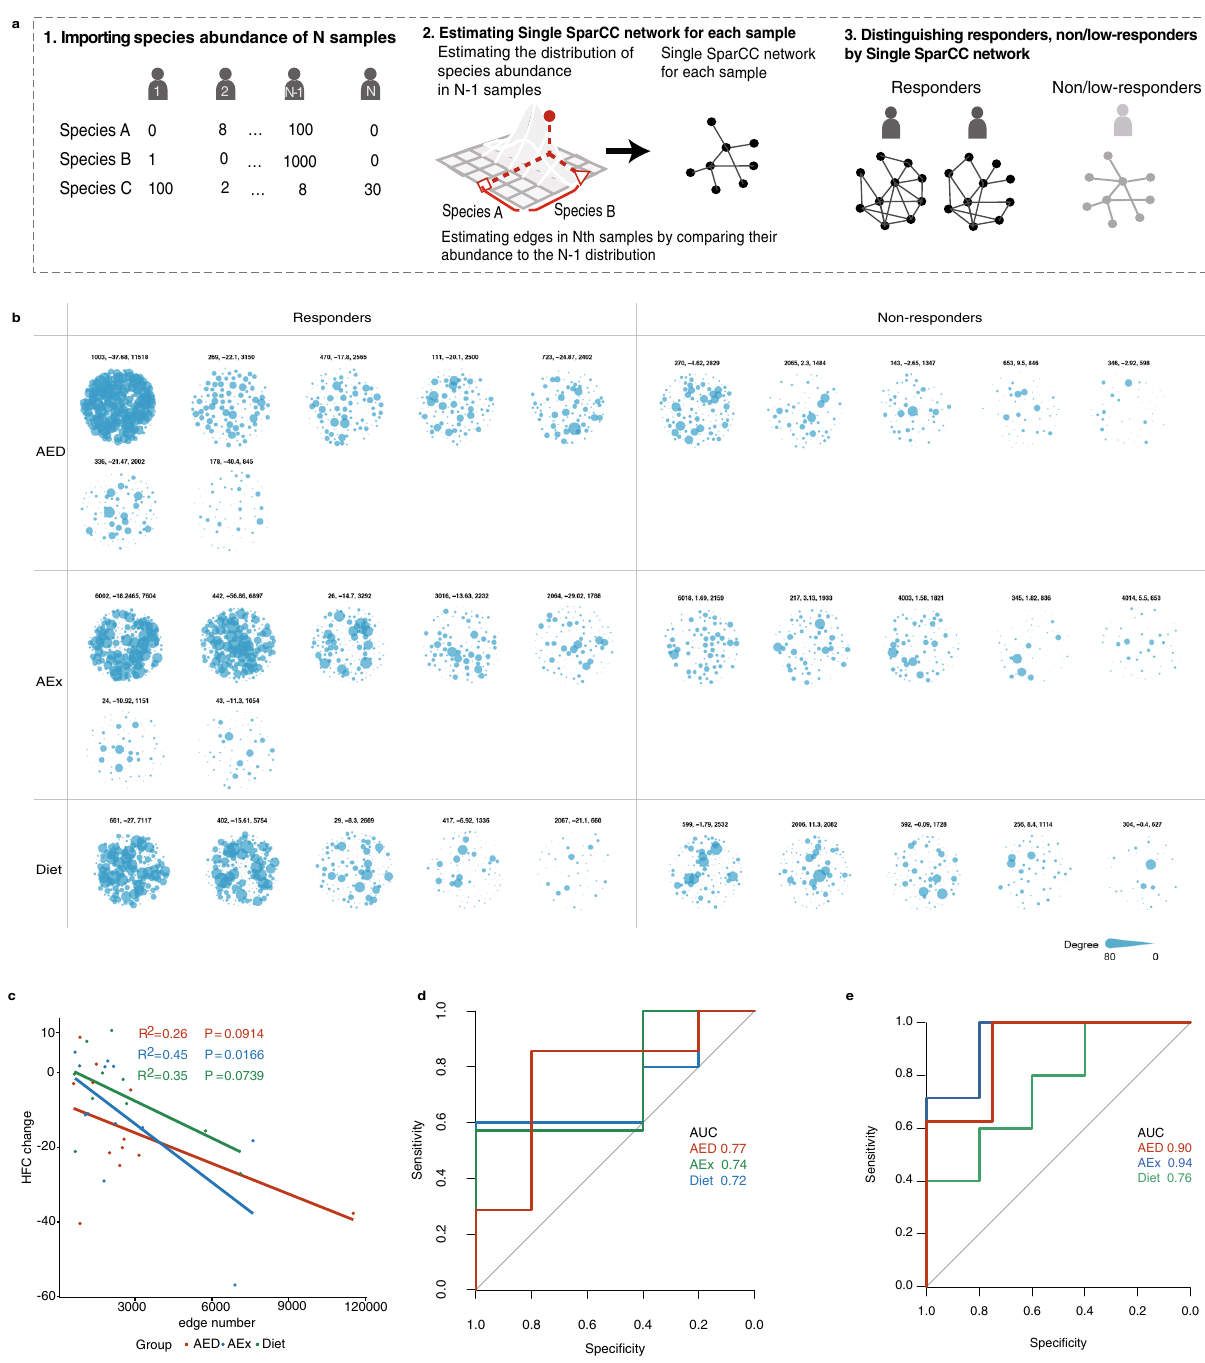
Fig. 5 Intervention ef fi ciency predicted by individual baseline gut microbial networks on metagenomics species data. a Prediction of responders using our single SparCC network method. b The gut microbial network for each individual before intervention based on metagenomics species data by the Single SparCC network method. Three numbers under every network represent subject ID, HFC change and edge numbers. c Linear regressions of edge number (Single SparCC network) with the change of HFC after intervention. AED: n = 12, AEx: n = 12, Diet: n = 10. d ROC curve of edge number for differential responders from low/non-responders within each intervention group by unsupervised classi fi cation. AED: n = 12, AEx: n = 12, Diet: n = 10. e ROC curve by supervised Lasso model performance. AED: n = 12, AEx: n = 12, Diet: n =